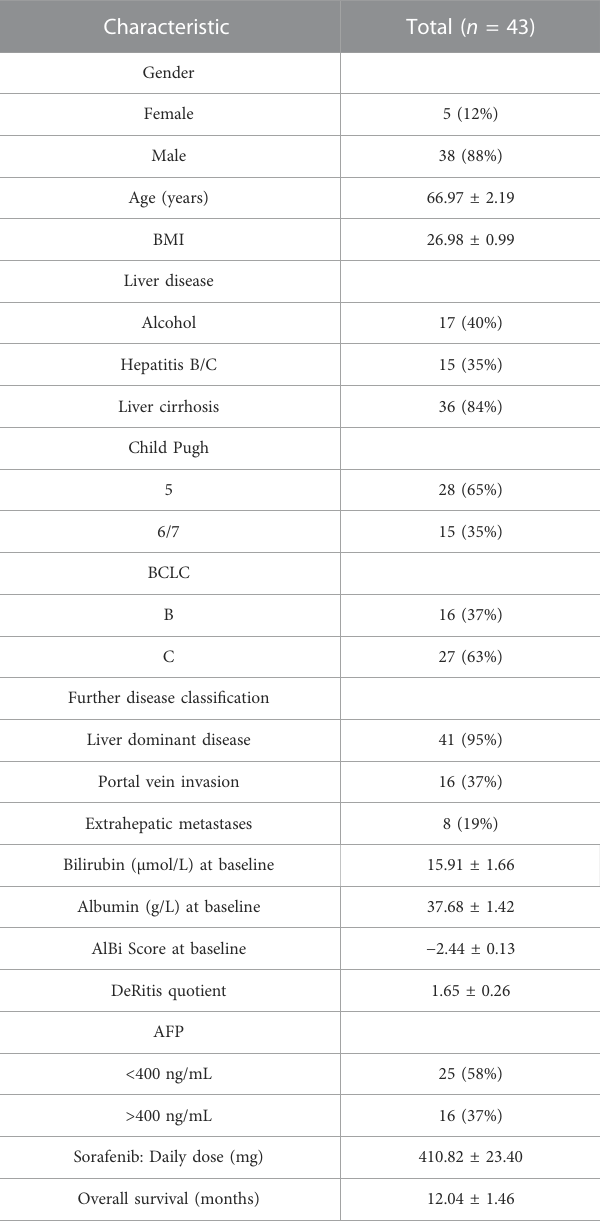
TABLE 1 Patient characteristics of the n = 43 HCC patients receiving sorafenib treatment. Data are presented as mean ± standard error of the mean.